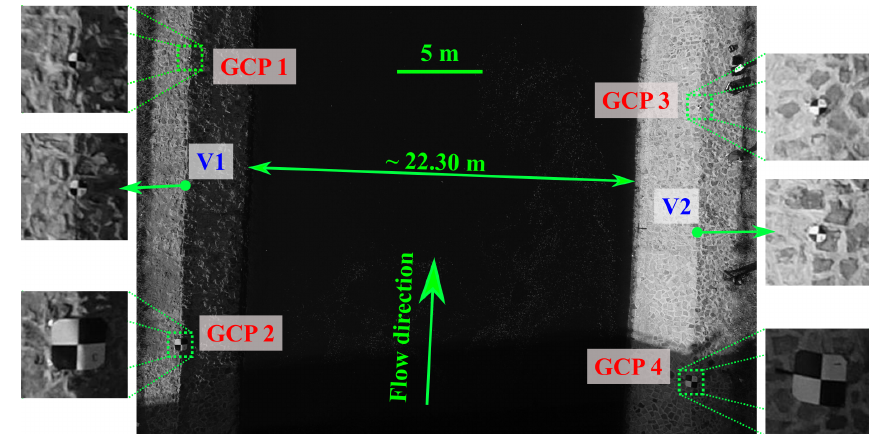
Figure 4. Region of interest and the distribution of ground control points for the case study 1 – Kolubara river.